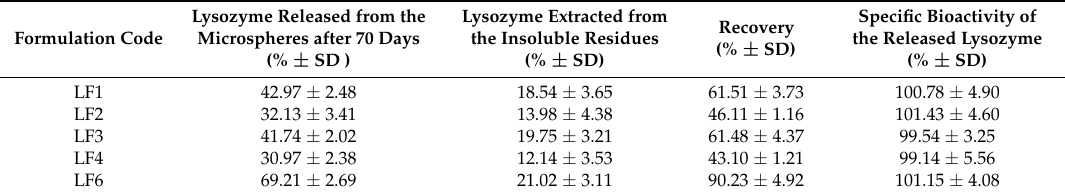
Lysozyme specific bioactivity and recovery from double-walled and single-walled microspheres prepared in different formulations.